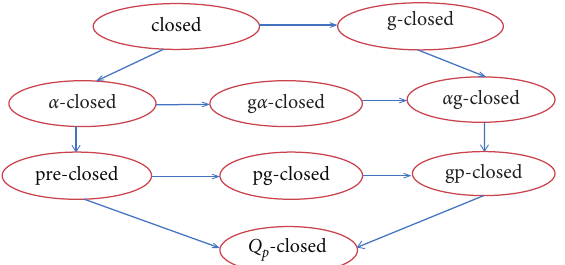
Figure 1: The relationship among the Q